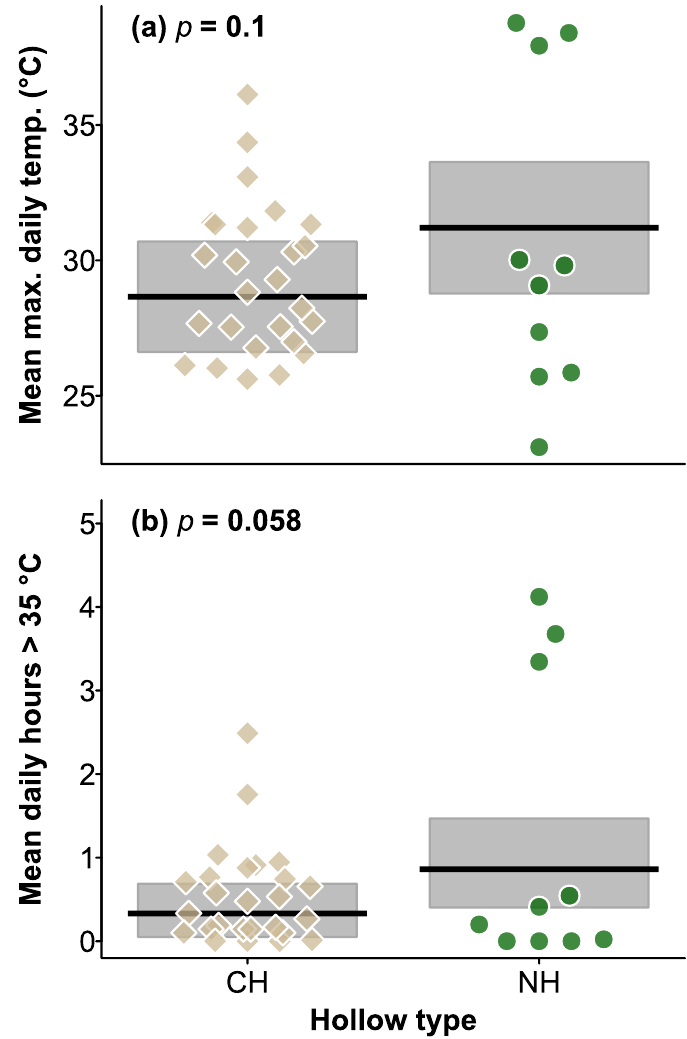
Figure 4. Plot of daily mean maximum temperature ( a ) and mean daily hours over 35 °C ( b ) in CHs and NHs. Shaded area are the 95% CI of the mean (black lines). p values for the effect of hollow type are shown at the top of the plots. Brown squares and green circles indicate mean values for CHs and NHs respectively in the 2018 – 2019 summer.